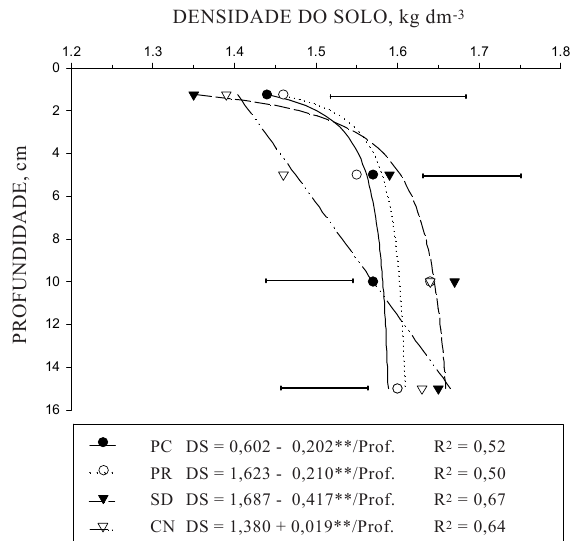
Figura 2. Densidade do solo, em diferentes profundidades sob diferentes sistemas de manejo. Os pontos representam a média dos tratamentos (n = 3). As barras horizontais indicam diferenças mínimas significativas entre mesma profundidade, calculadas pelo teste de